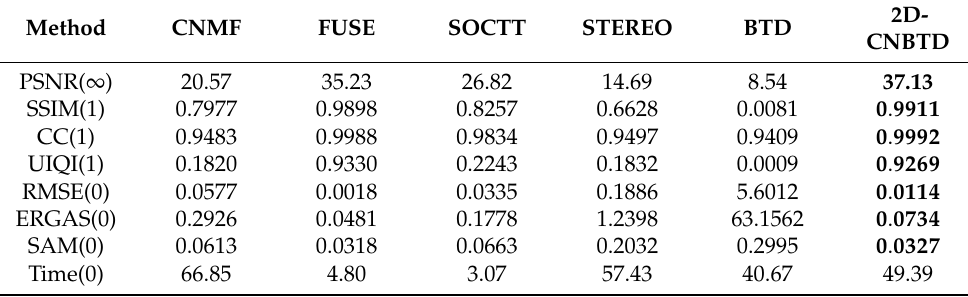
Table 5. Performance for UAV acquisition of Qingtongxia rice